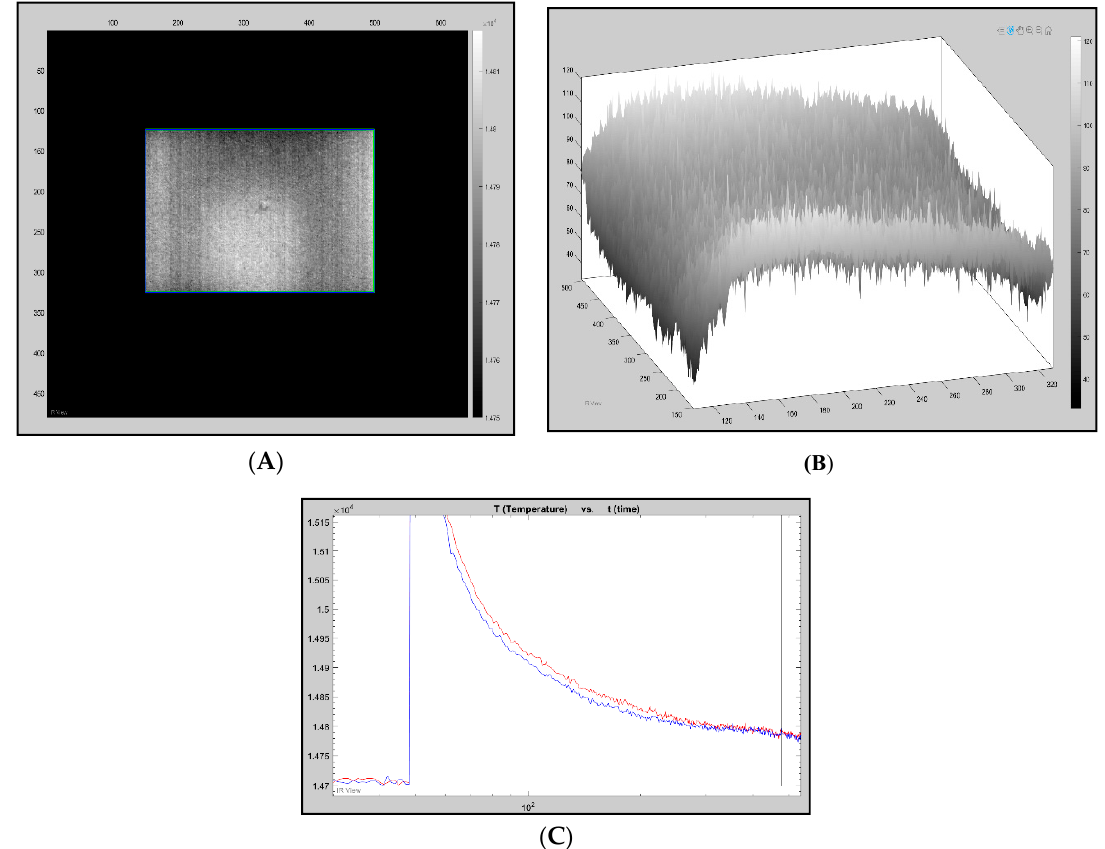
Figure 17. ( A ) Focused image of frame 480 of sample 3.2uncooledfront surface. The damage is visible in the noisy dataset which also contains some reflectance. ( B ) 3D pixel map of sample 3.2uncooledfront surface, frame 480. ( C ) Temperature/time graph from 3.2 front surface uncooled (red—defect area pixel; blue—sound area pixel).